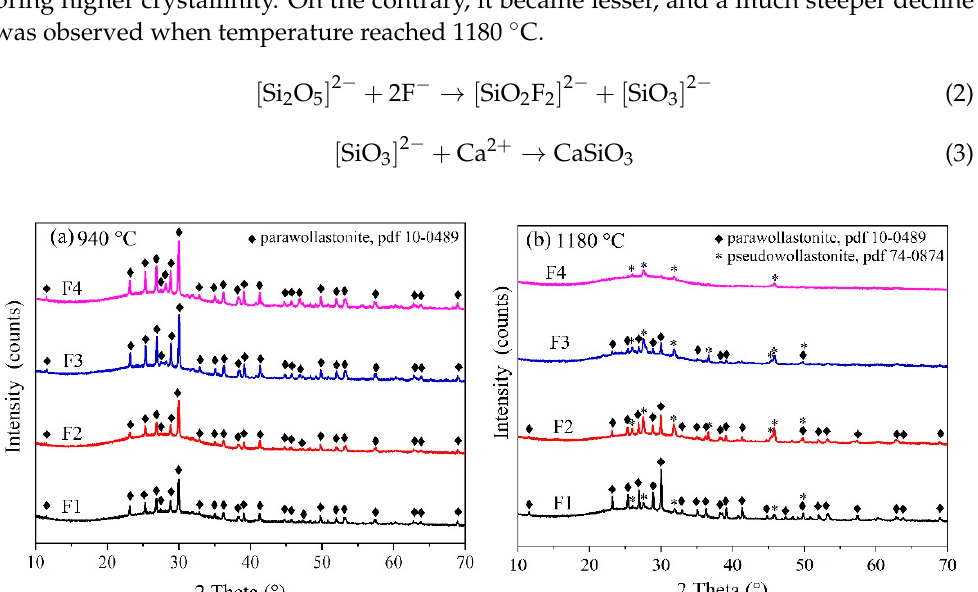
Figure 3. XRD results of wollastonite glass-ceramics obtained by heat treatment at different tem- peratures ( a ) 940 ° C, ( b ) 1180 ° C.